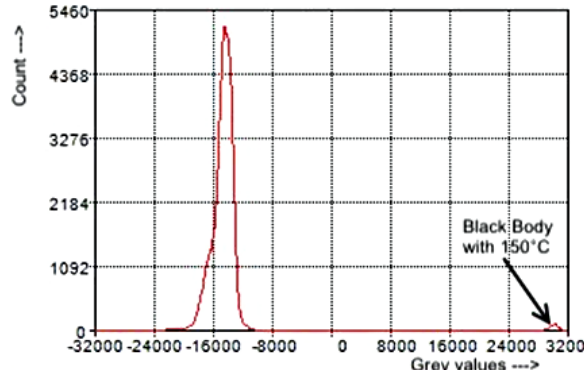
Figure 9. Histogram of the raw image at the operating point show- ing a black body with a temperature of 150 ◦ C (microbolometer with 384 × 288